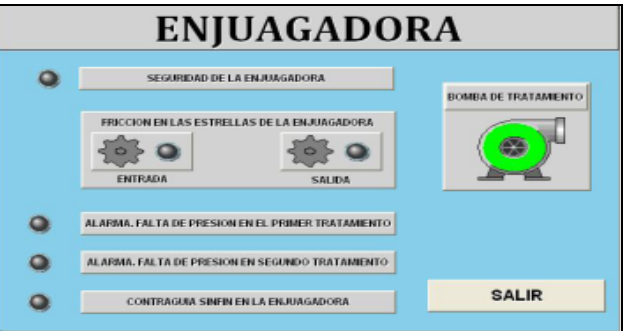
Figura 3: Enjuagadora en el monobloque. Fuente: Los Autores, (2018).